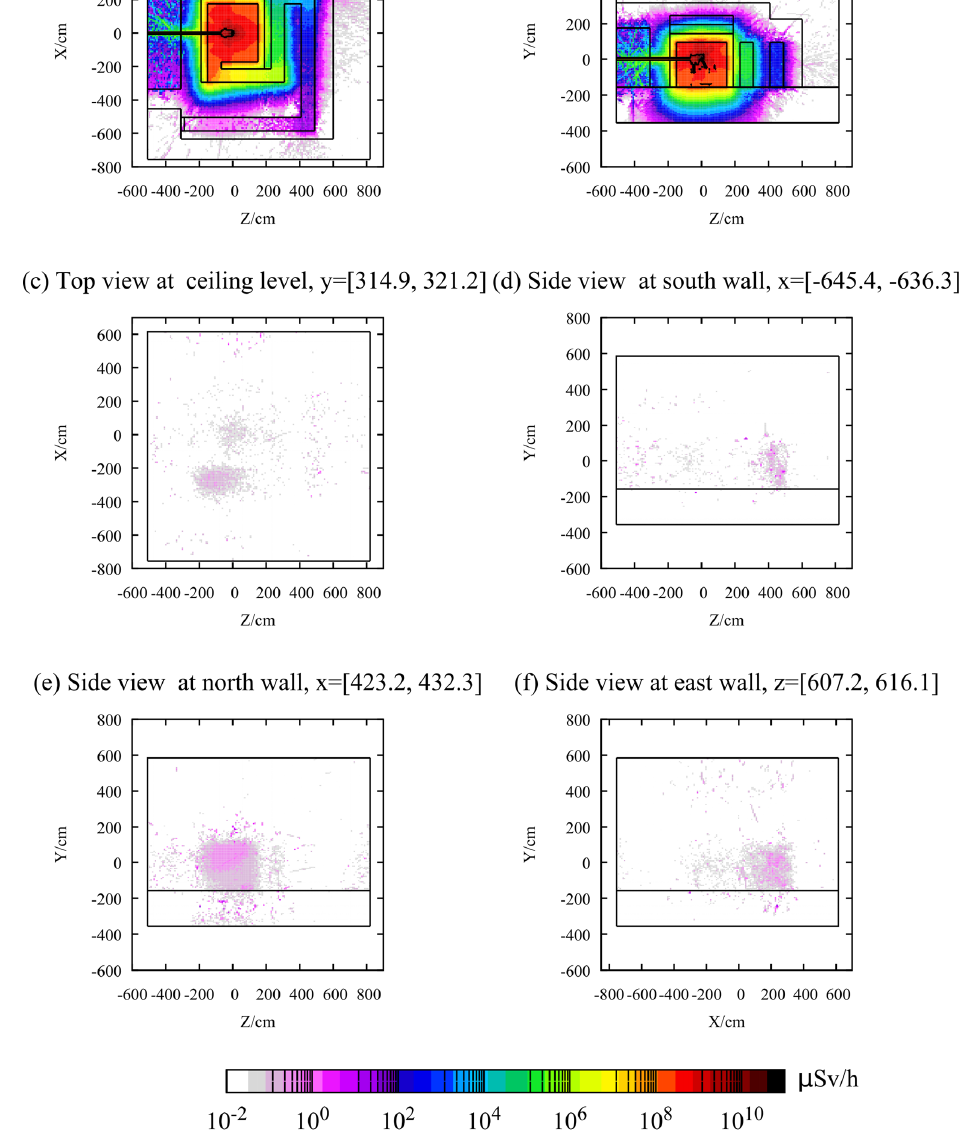
Figure 11. Prompt ambient dose equivalent rate distribution ( μ Sv/h) in the target terminal.